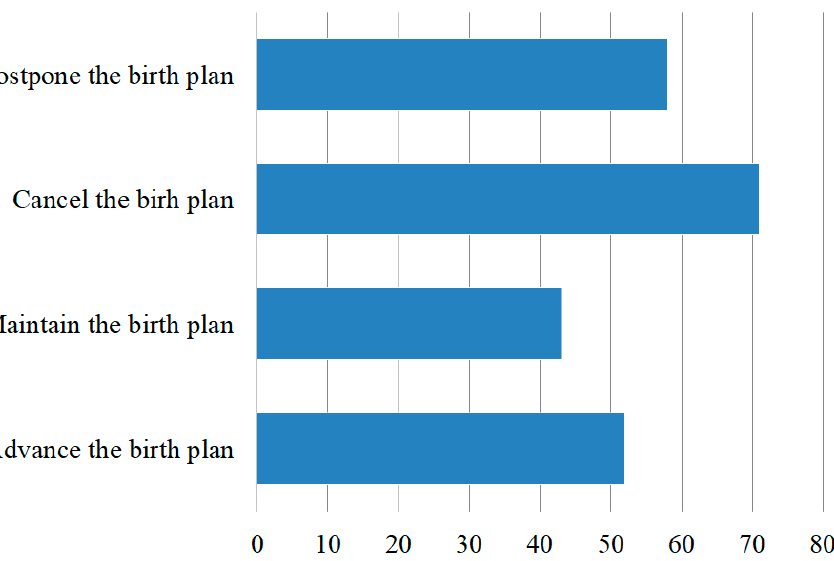
Figure 2. A map of changes in the fertility intentions of women of childbearing age affected by COVID-19.